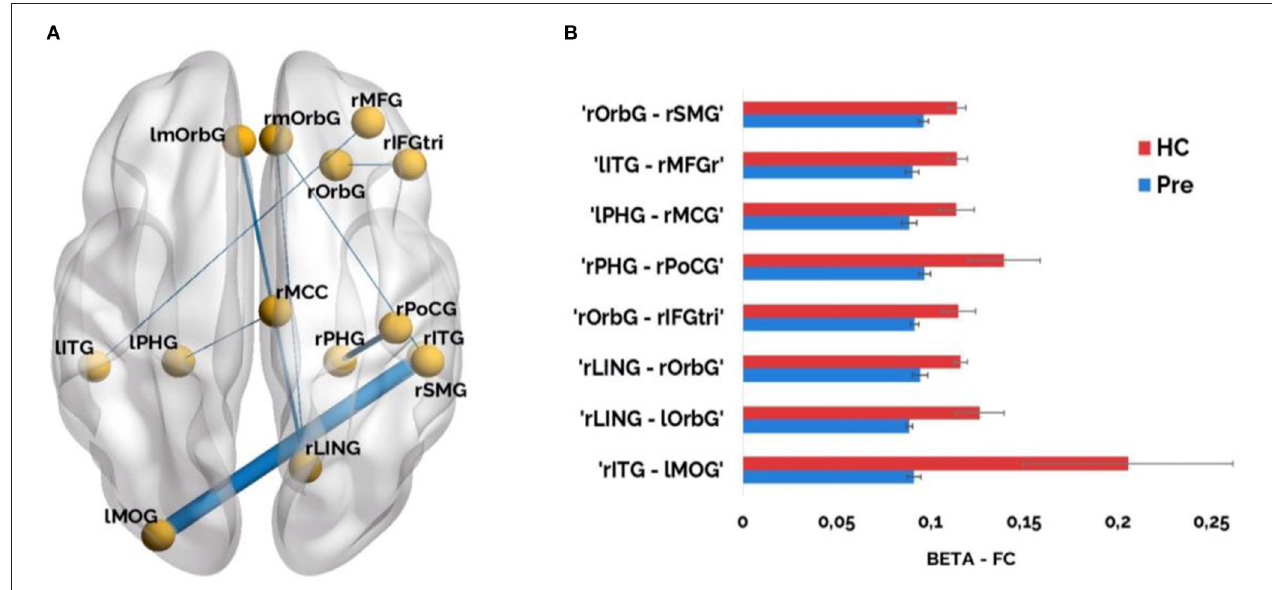
FIGURE 3 | (A) Significant FC results ( p < 0.005, corrected) in the beta band (12–30Hz) when comparing healthy controls vs. stroke patients in the pre-condition. Line thickness of significant links is proportional to FC values (a higher value corresponds to thicker lines, and vice versa); (B) Significant FC links in the beta band are represented as bar graphs. Red color represents higher connectivity values for healthy controls compared to stroke patients and blue color illustrates lower connectivity values for stroke patients compared to healthy controls. ROIs included: rmOrbG, Right Medial Orbito Frontal Gyrus; lmOrbG, Left Medial Orbito Frontal Gyrus; rMFG, Right Middle Frontal Gyrus; rOrbG, Lateral Orbito Frontal Gyrus; rIFGtri, Right Inferior Frontal Parstriangularis; lITG, Left Inferior Temporal Gyrus; rITG, Right Inferior Temporal Gyrus; lPHG, Left Parahippocampal Gyrus; rPHG, Right Parahippocampal Gyrus; rMCC, Right Posterior Cingulate Gyrus; rPoCG, Right Postcentral Gyrus; rSMG, Right Supramarginal Gyrus; rLING, Right Lingual Cortex; lMOG, Left Lateral Occipital Gyrus.